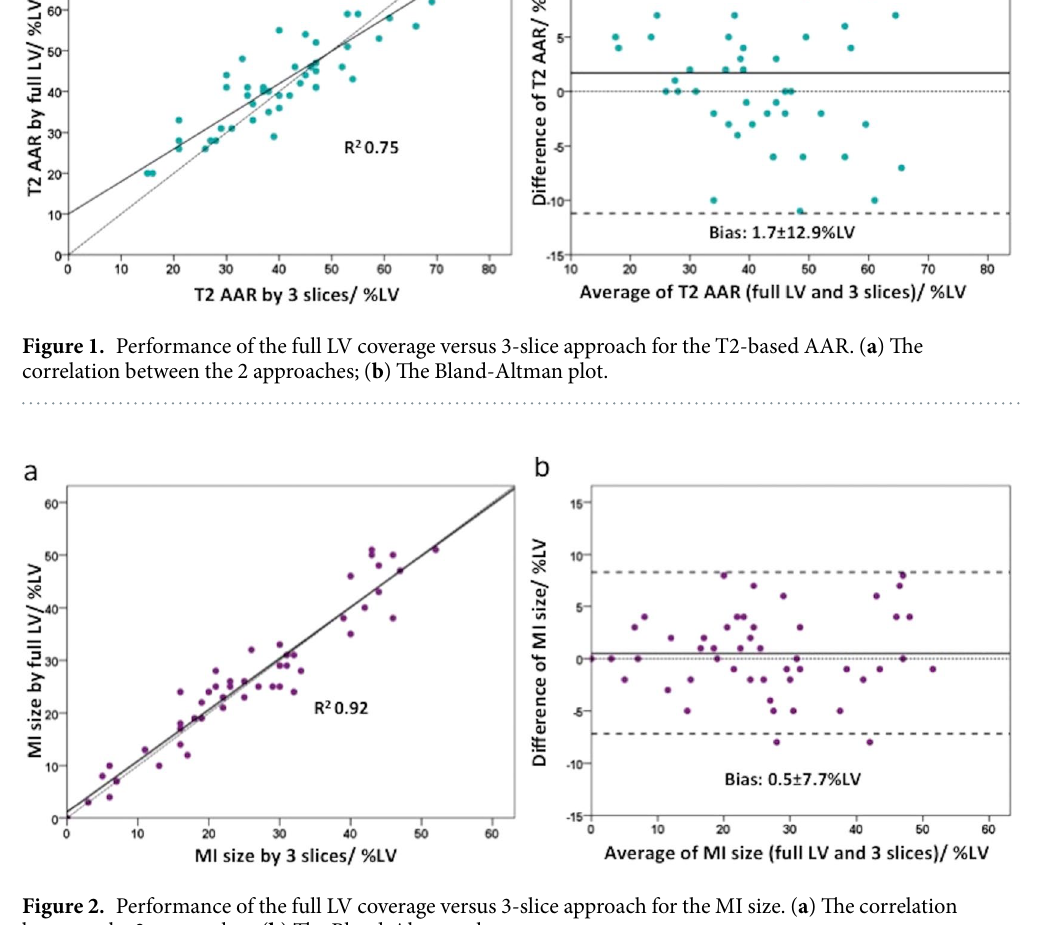
Figure 2. Performance of the full LV coverage versus 3-slice approach for the MI size. ( a ) The correlation between the 2 approaches; ( b ) The Bland-Altman